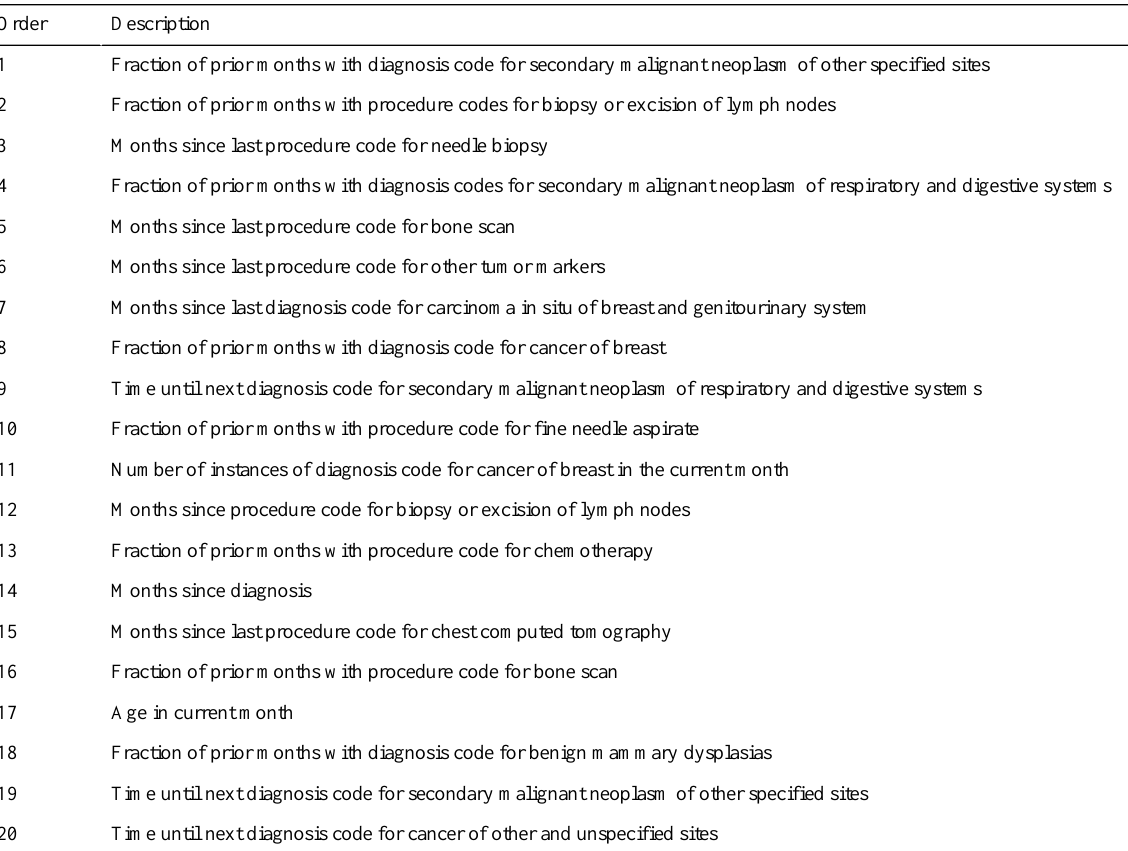
Table 1. Top 20 features identified by the gradient boosting algorithm. DescriptionOrder